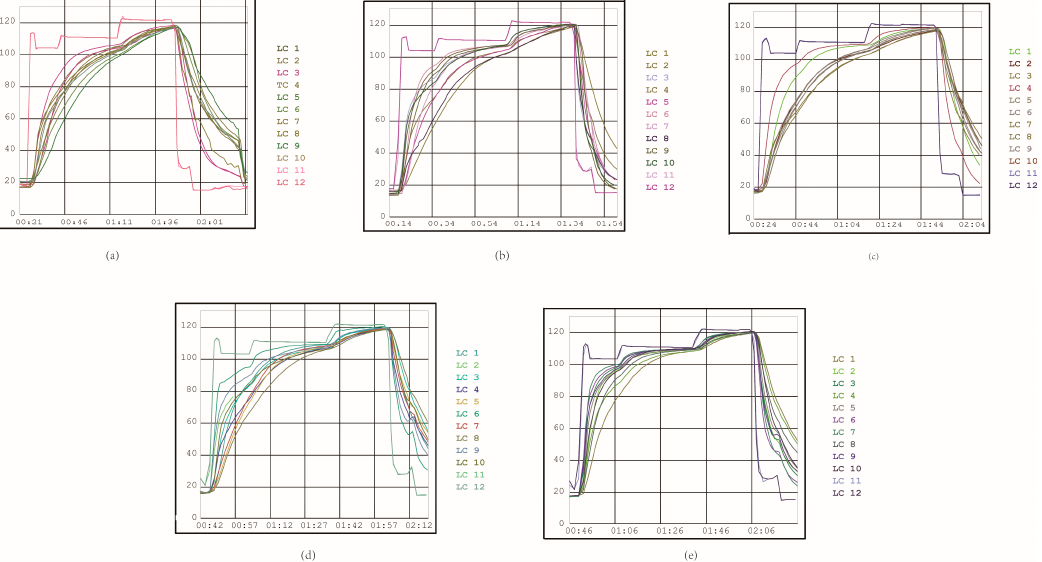
Figure 1. Heat penetration curves of 1 kg/bag of ( a ) fish fillet in chili sauce, ( b ) preserved vegetables and pork, ( c ) fried mixed vegetables, ( d ) roast pork with bamboo shoots, and ( e ) stewed bamboo products in sterilization workshop. Table 1. Changes in the amount of food bacteria before and after GCT.